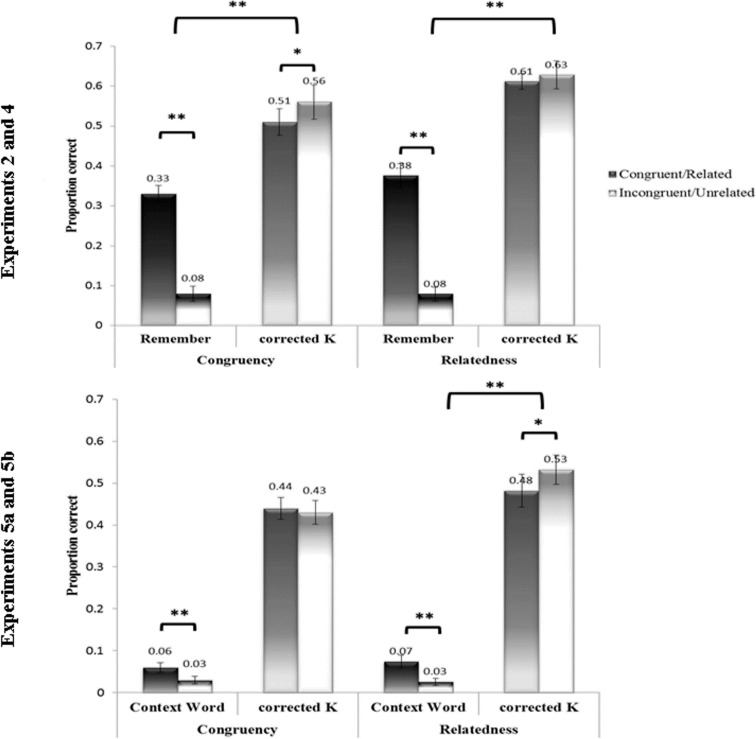
Remember and corrected K rates in Congruency and Relatedness.Upper panel: Experiments 1 and 3, in which participants examined the semantic relations between the components of the stimuli. Lower panel: Experiments 4a and 4b, where participants examined the lexical status of the items (nouns or adjectives).